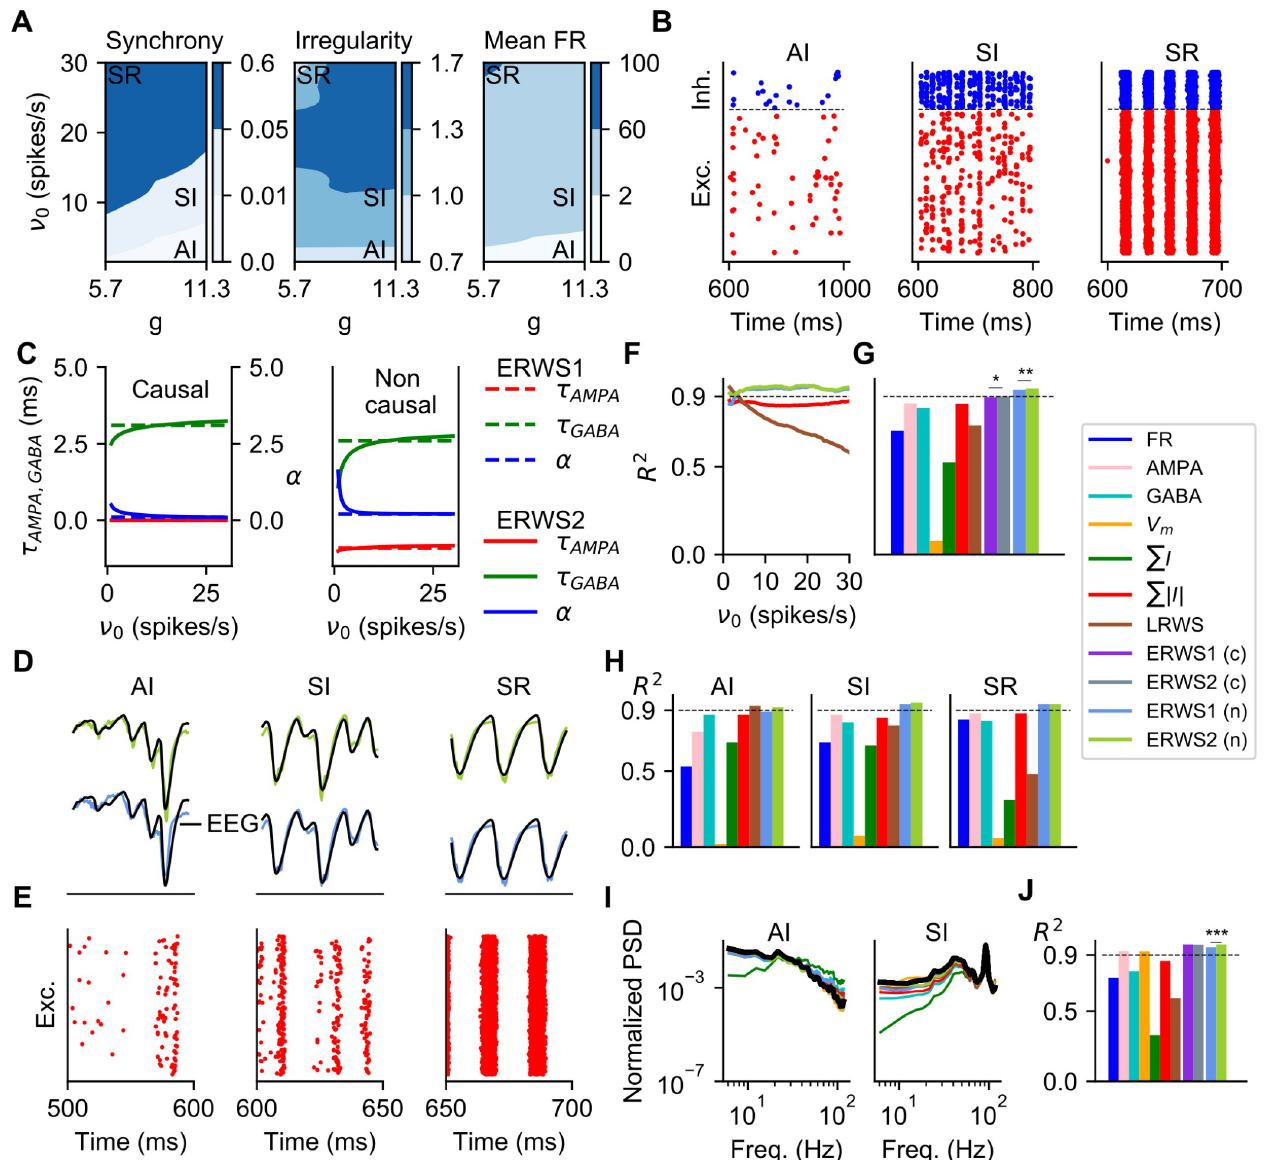
Fig 2. Optimization and validation of proxies for different sets of network parameters ( ν , g ). (A) Dynamic states of network activity defined by the 0 control parameters g and ν 0 . The labels AI (asynchronous irregular), SI (synchronous irregular) and SR (synchronous regular) indicate the combinations of parameters that have been selected as representative samples of each network state. The synchrony and irregularity are unitless, the mean firing rate (FR) is measured in spikes/s. (B) Spiking activity from a subset of cells of the excitatory and inhibitory populations for the same samples shown in (A). (C) . We considered two alternative scenarios. In the causal Optimized parameters of ERWS1 and ERWS2 (Eqs 7–9) as a function of the thalamic firing rate ν 0 version of the proxy, the output depends only on present and past inputs so that the time delay parameters ( τ and τ ) are constrained to be positive. AMPA GABA In contrast, non-causal proxies can be assigned positive or negative time delays. (D) Outputs of non-causal ERWS1 (bottom row) and non-causal ERWS2 (top row) proxies for different network states compared to ground-truth EEGs. (E) Spiking activity for the same simulation cases of panel D. (F) Average performance, evaluated by using the coefficient of determination R 2 , of ∑ | I |, LRWS , ERWS1 (non-causal) and ERWS2 (non-causal) calculated on the validation dataset as a function of ν (same colors as shown in (G)). The dotted line R 2 = 0.9 was chosen arbitrarily as a reference value of good performance 0 and was used only for visual inspection of results. (G) Average R 2 of every proxy across all network instantiations i of the validation dataset ( c is causal, n is non-causal). The same colors shown in this legend are used throughout the article to identify the different proxies. Tests for statistical significance are computed only for the pair ERWS1 (non-causal) and ERWS2 (non-causal) and for the pair ERWS1 (causal) and ERWS2 (causal). (H) R 2 across network states. (I) Power spectral density (PSD) of the proxies and the EEG (in black). (J) Average R 2 computed across the 5–200 Hz frequency range of the log 10 (PSDs) of all network instantiations i of the validation